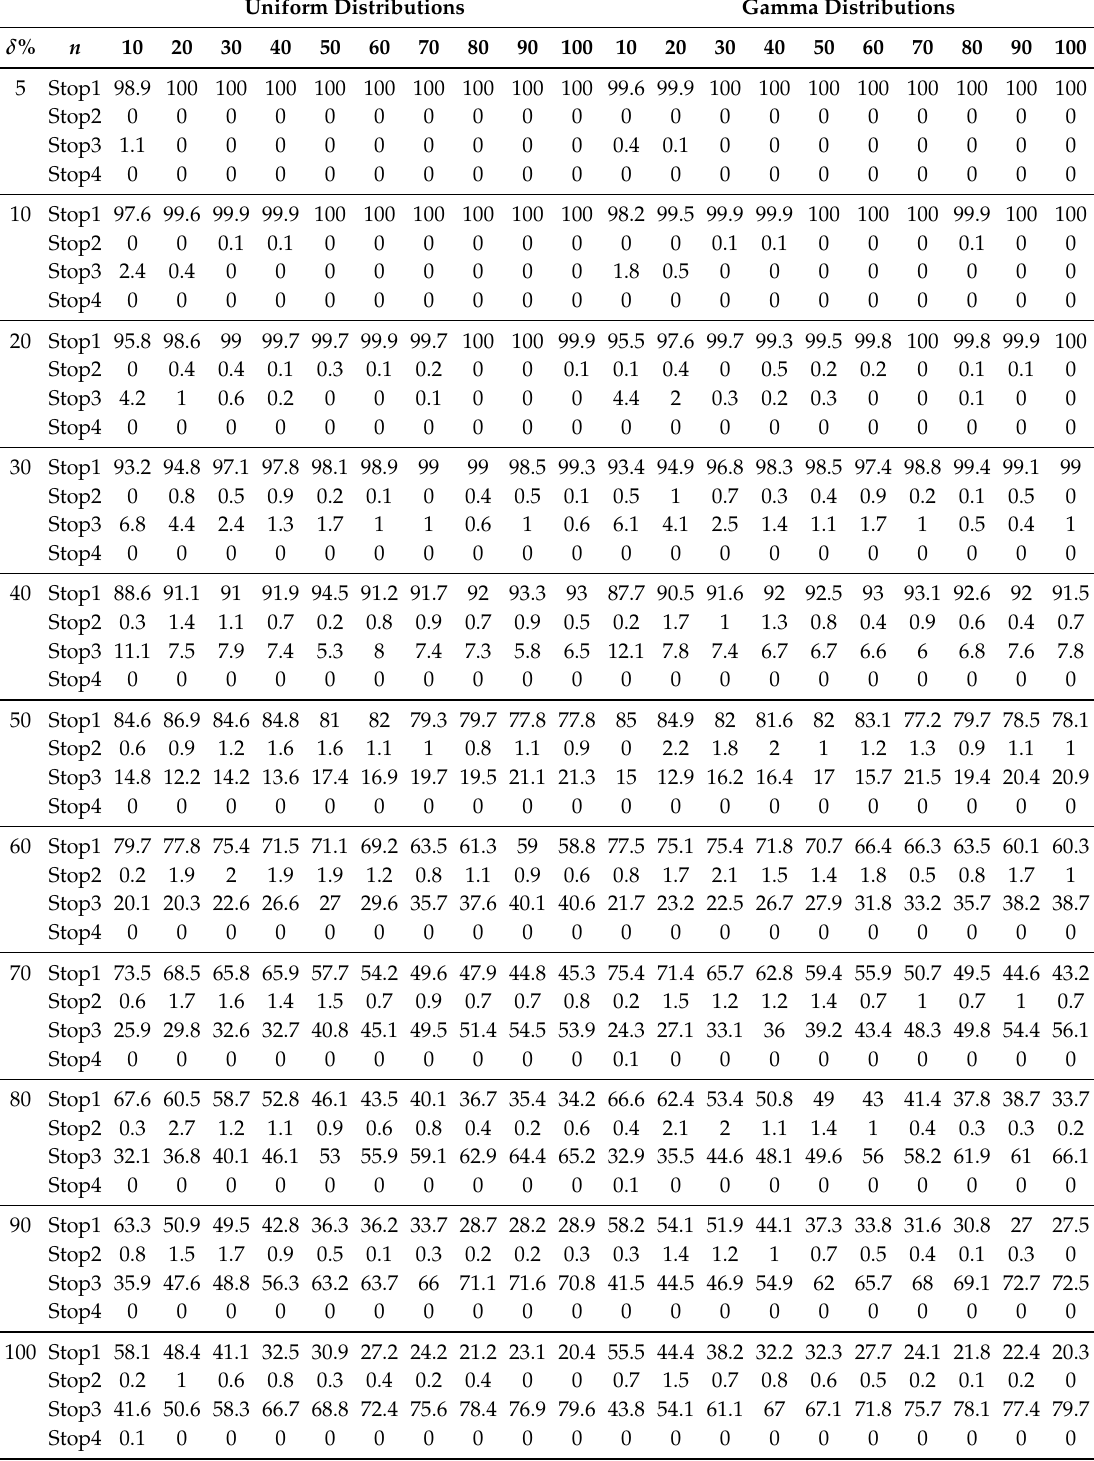
Table A13. Computational results for randomly generated instances with the ratio 10%:40%:10%:40% of the numbers of jobs in the subsets J 1 , J 2 , J 1,2 and J 2,1 of the job set J